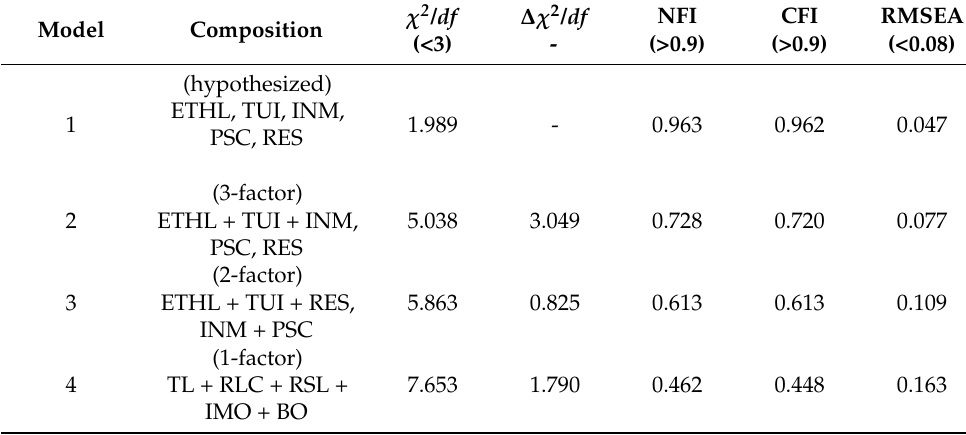
Table 4. Model fit comparison, alternate vs. hypothesized